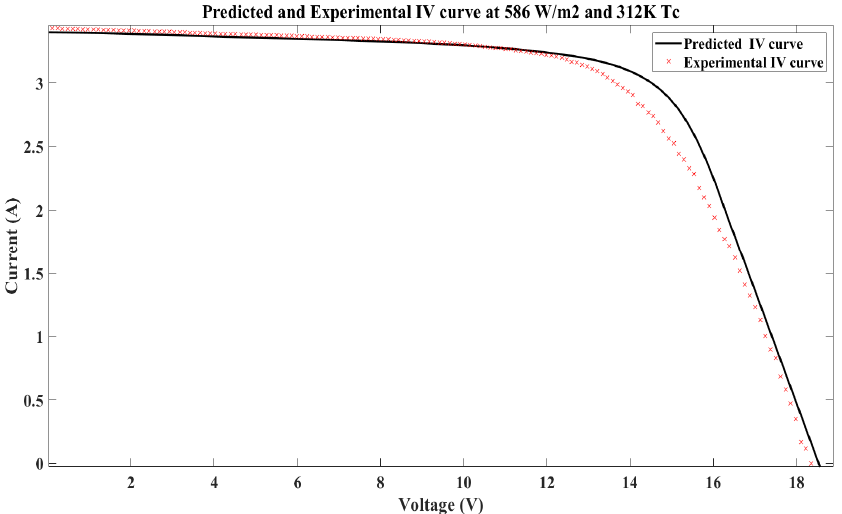
Figure 8. Predicted and experimental IV curves for thin module at 586 W/m 2 and 312K Tc.